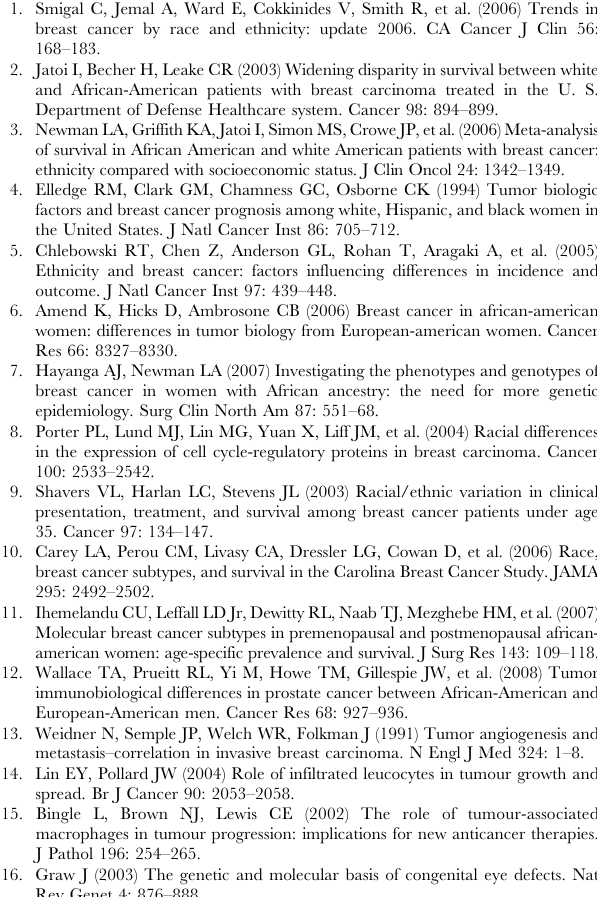
Found at: doi:10.1371/journal.pone.0004531.s002 (0.04 MB PDF)